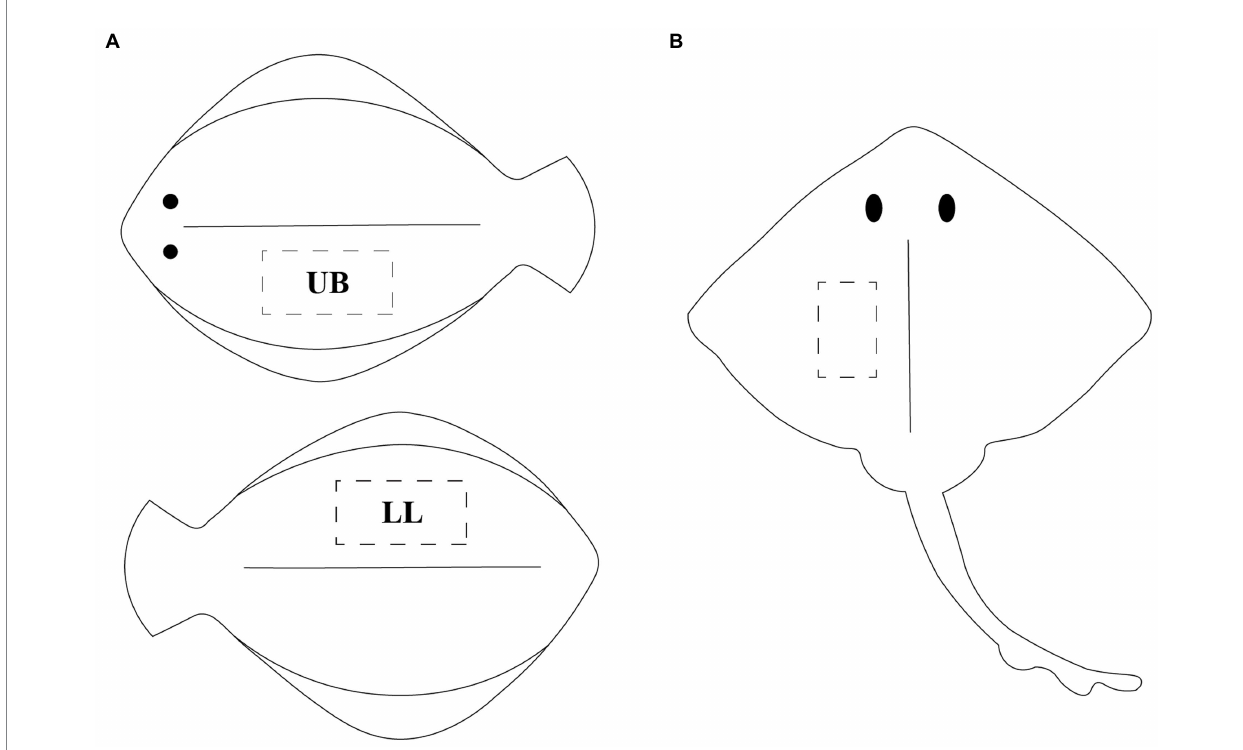
FIGURE 1 (A) Graphical illustration of flatfish, visualizing the two sampling points upper belly (UB) on the upper body part and lower loin (LL) on the back side of the fish; (B) illustration of ray, visualizing the sampling point of the central